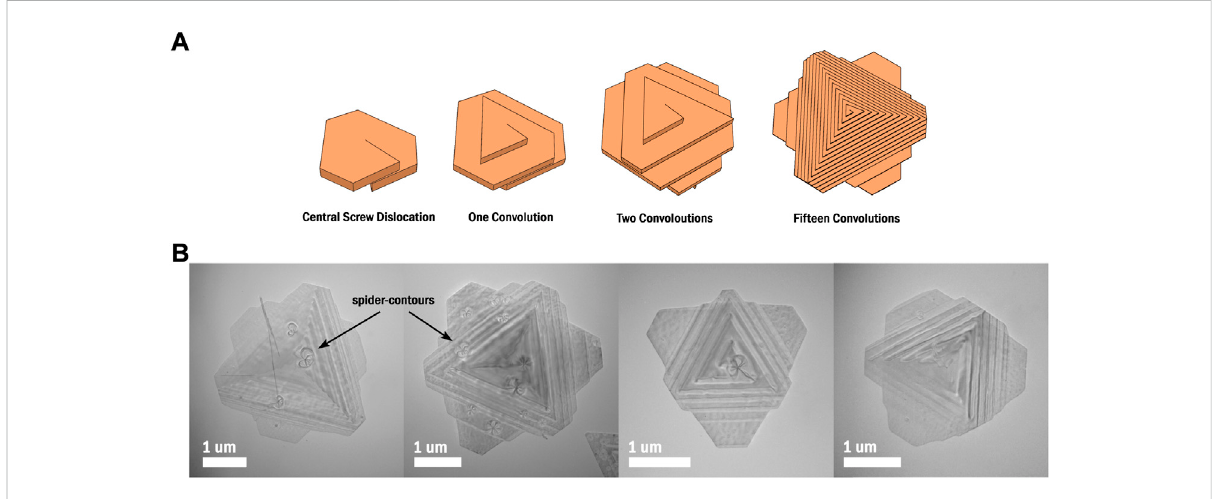
FIGURE 1 (A) An illustration of the growth process of spiral Sb 2 Te 3 nanoplates. (B) A selection of TEM images showing spiral Sb 2 Te 3 nanoplates of slightly different sizes and morphologies, some with